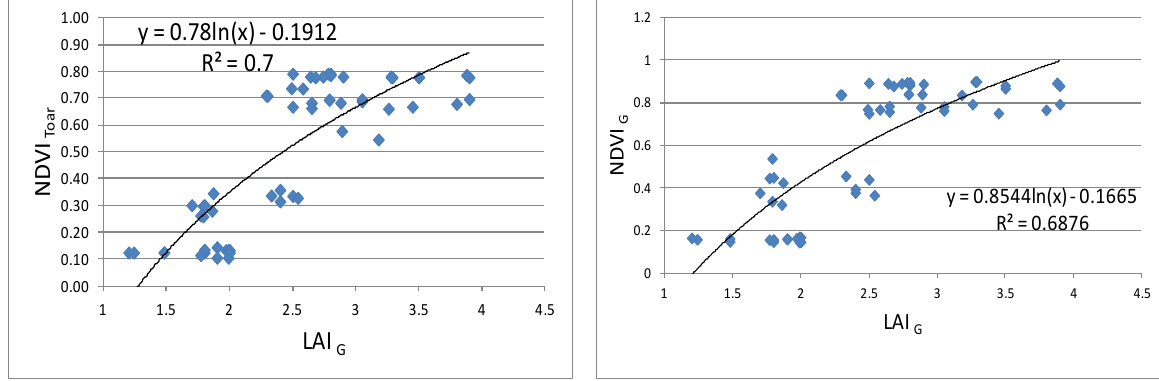
Figure 7: Relationship of LAI G and NDVI Toar for wheat crop